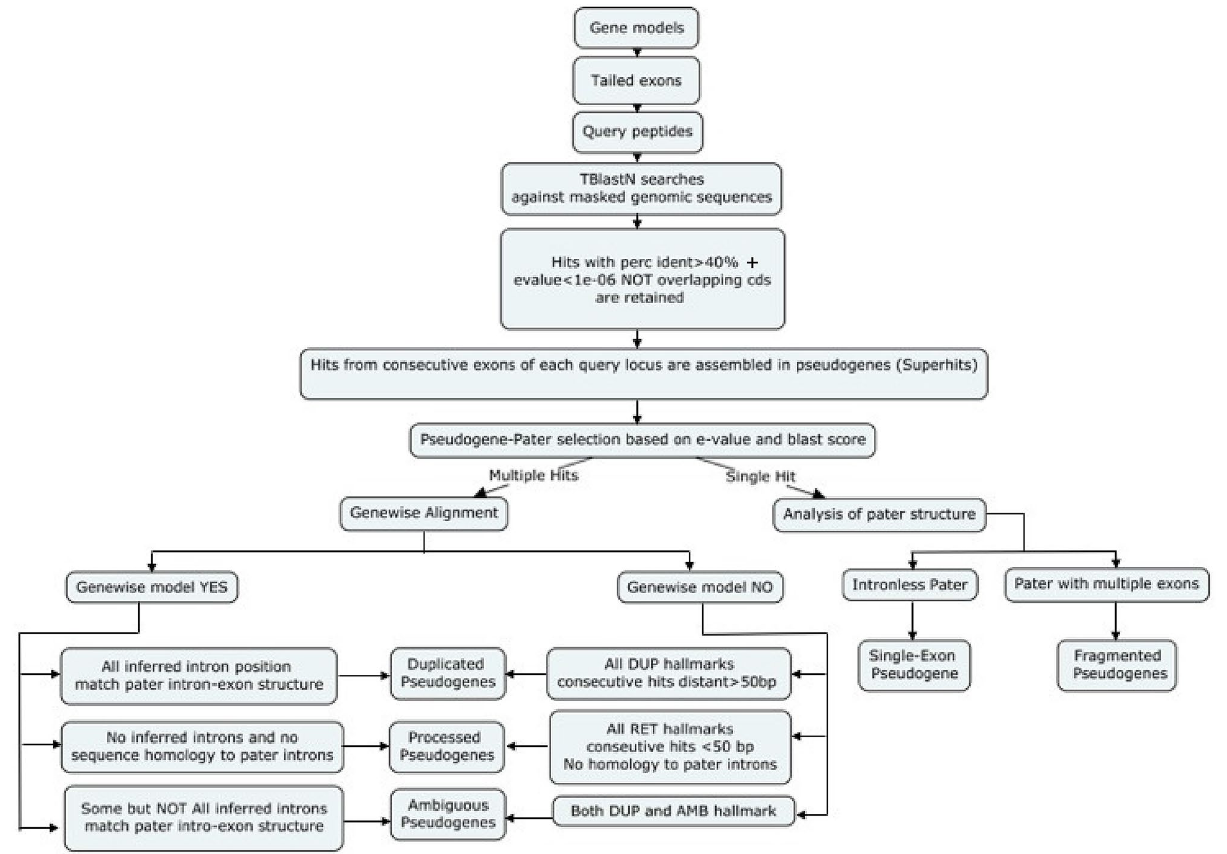
Figure 1. Procedures followed to identify and classify the pseudogenes based on their inferred intron-exon structures. DUP duplication, RET retroposition, AMB